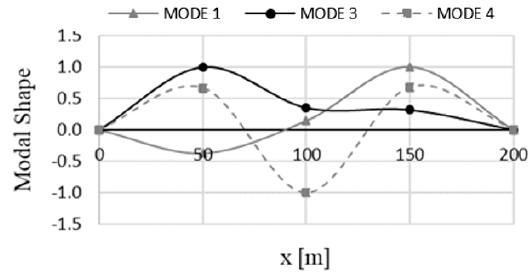
Figure 11. Irregular bridge—mode shapes (transverse direction).